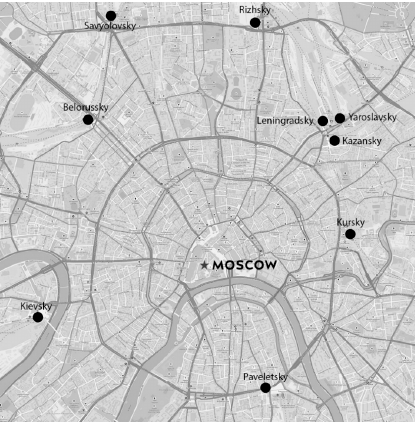
Figure 1. Location of rail stations on the map of Moscow.